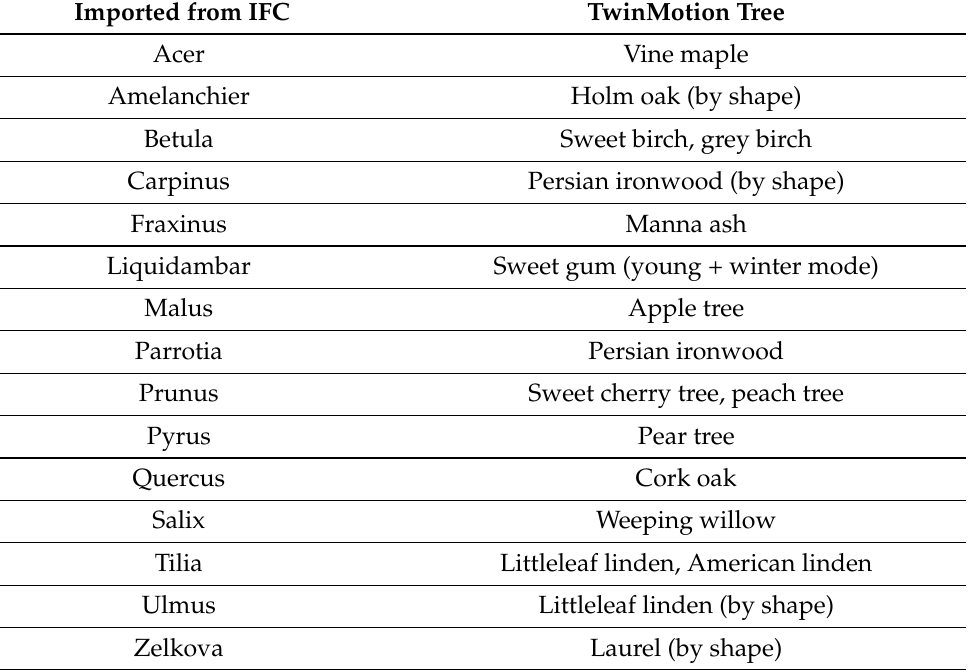
Table A1. Table of tree mesh